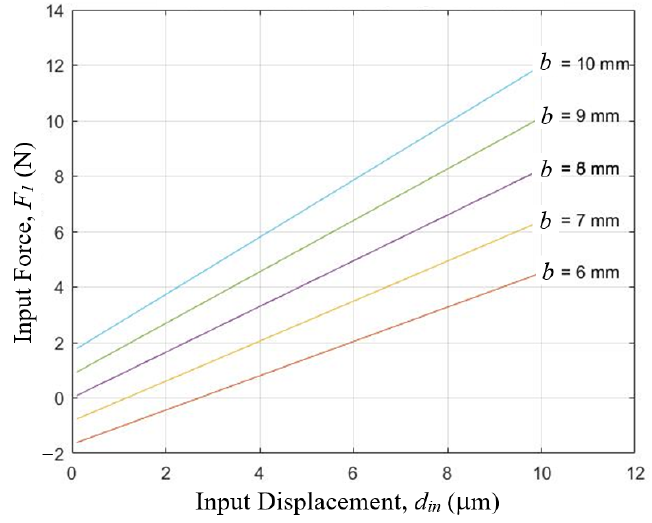
Figure 14. Relations between input force and input displacement of a three-stage cascaded lever structure at different hinge width b , when hinge thickness t = 0.1 mm, as computed by Equation (12) of the simplified analytical